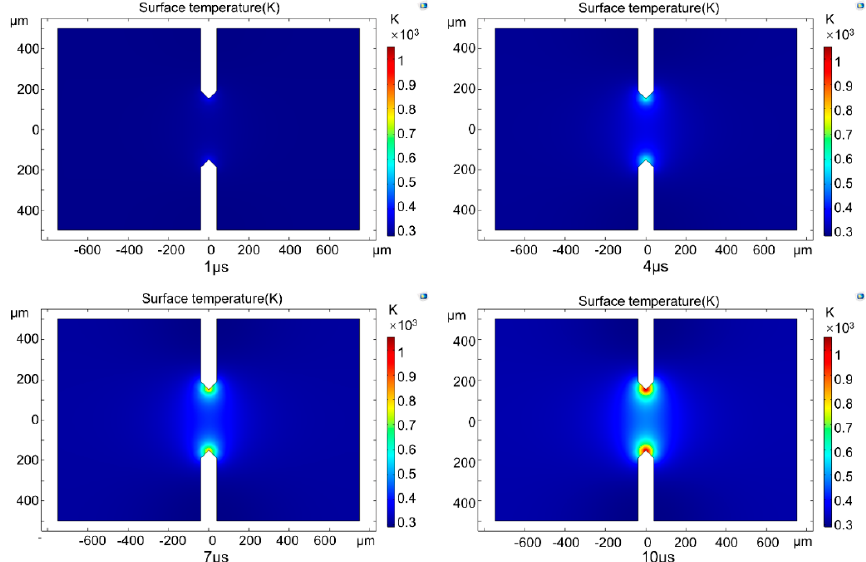
Figure 4. The typical surface temperature of SCBs at 1 µs, 4 µs, 7 µs, and 10 µs under 20 V, the V-shaped corner of SCBs has a maximum heating rate.